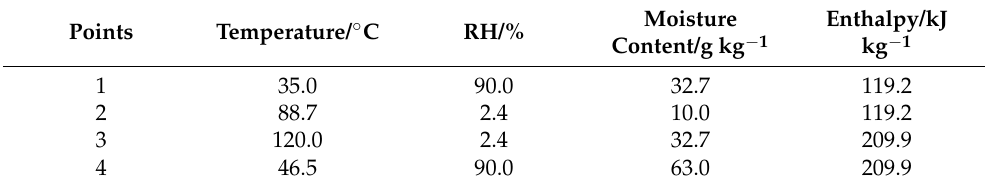
Table 6. Inlet and outlet status